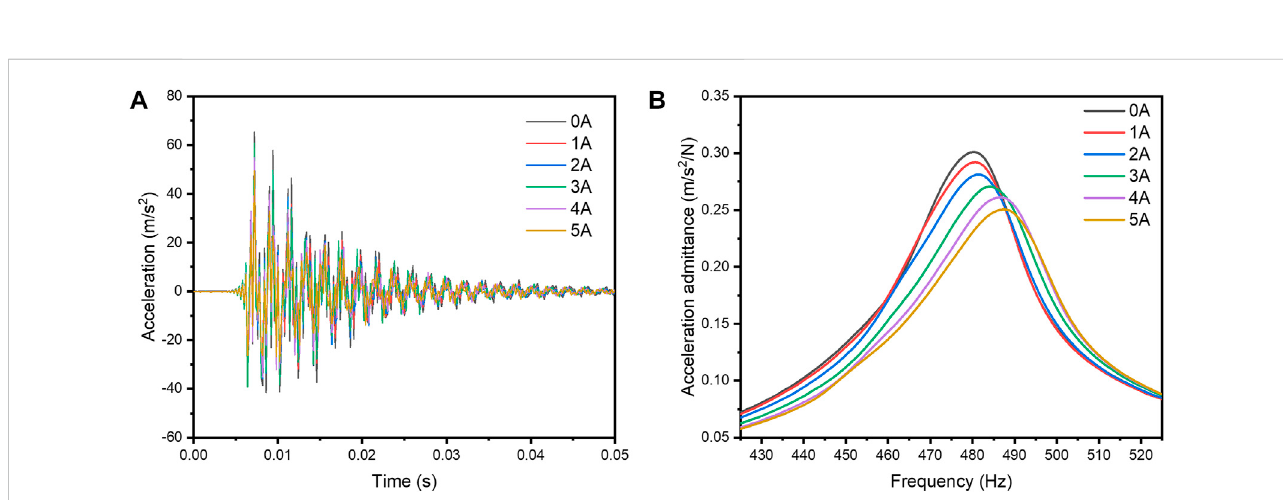
FIGURE 10 The acceleration (A) and frequency response function (B) of the MRE railway pad with different coil ’ s currents.